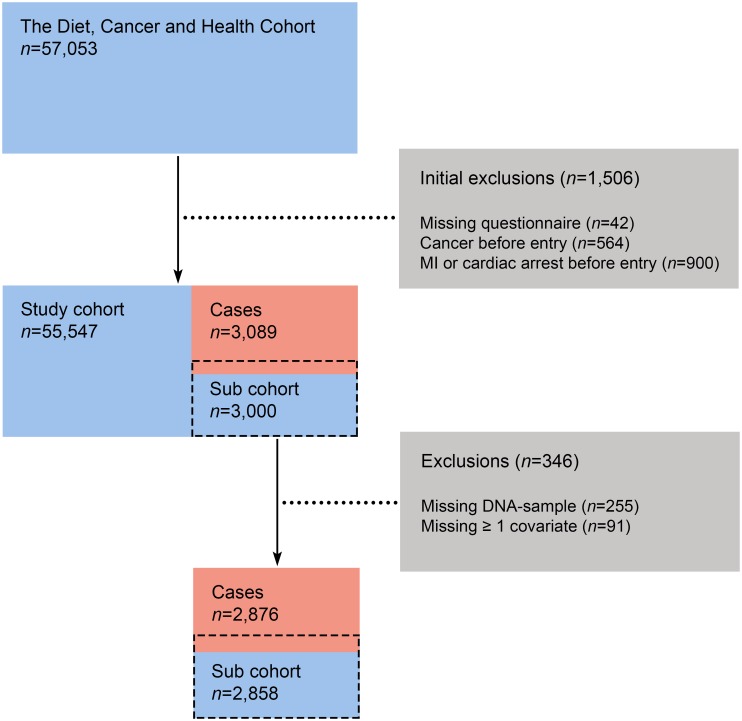
Flow chart of cohort selection process.